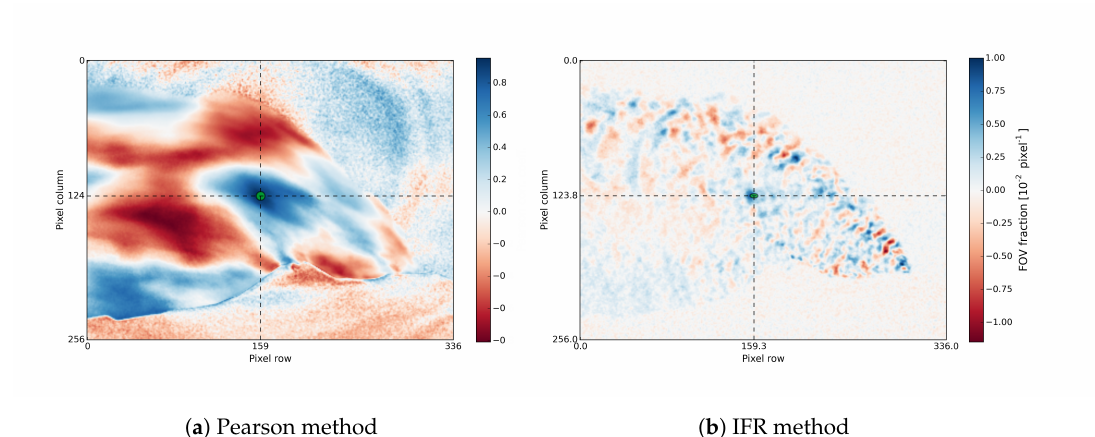
Figure 7. DOAS FOV search. DOAS FOV search results using ( a ), the Pearson and ( b ), the IFR method. The Pearson method (a) yields an FOV centered at i = 159, j = 124 and a disk radius of four pixels. For the IFR retrieval (b), a tolerance factor of λ = 2 × 10 − 3 was chosen and a Super-Gaussian (without tilt) was fitted to the correlation image yielding an FOV centered at i = 159.3, j = 123.8, σ = 7.1, asymmetry parameter a = 1.9 and a shape parameter of b = 0.3 (for details see Equation (A2)). The retrieved FOV positions show good agreement. Note that the FOV was retrieved from downscaled images (Gauss pyramid level 2).